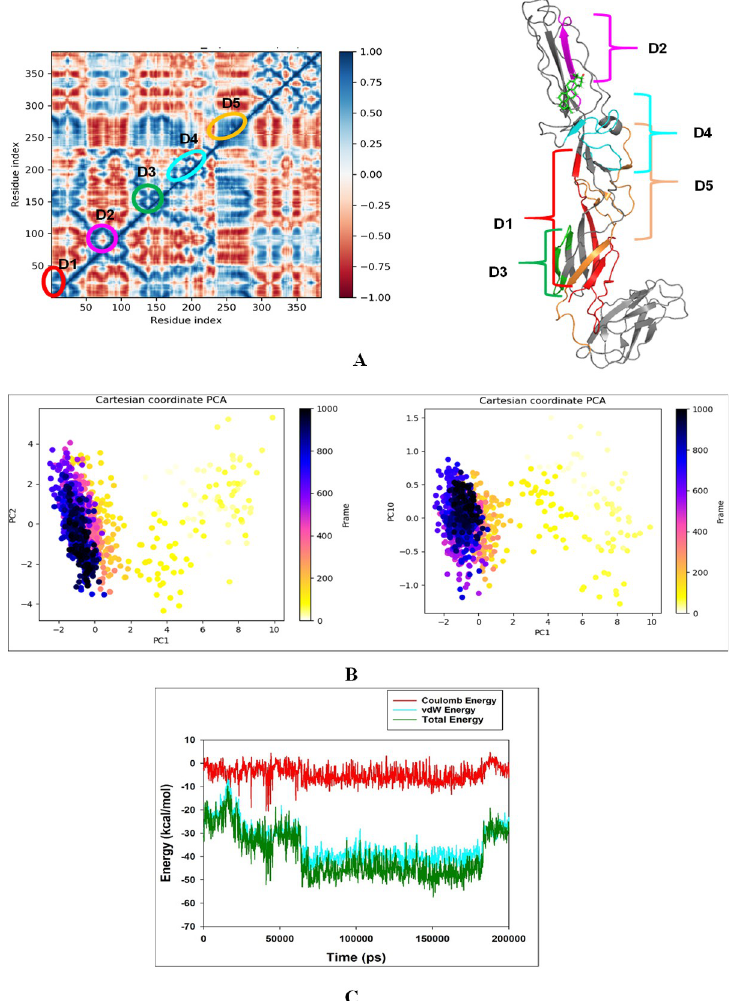
Fig 9. A. Dynamic Cross Correlation matrix (DCCM) of 2ALA and correlated amino acids conformed into secondary structural domains (colored) and non-correlated domains (grey) of 2ALA; B. PCA of 2ALA-Lupenone showing a stable configuration; C . Energy plot of protein 2ALA and Lupenone complex system during the entire simulation event of 200 ns. The total energy (dark green), van der Waal’s energy (cyan) and coulomb energy (red) of the entire system indicate the stability of the individual systems bound to Lupenone